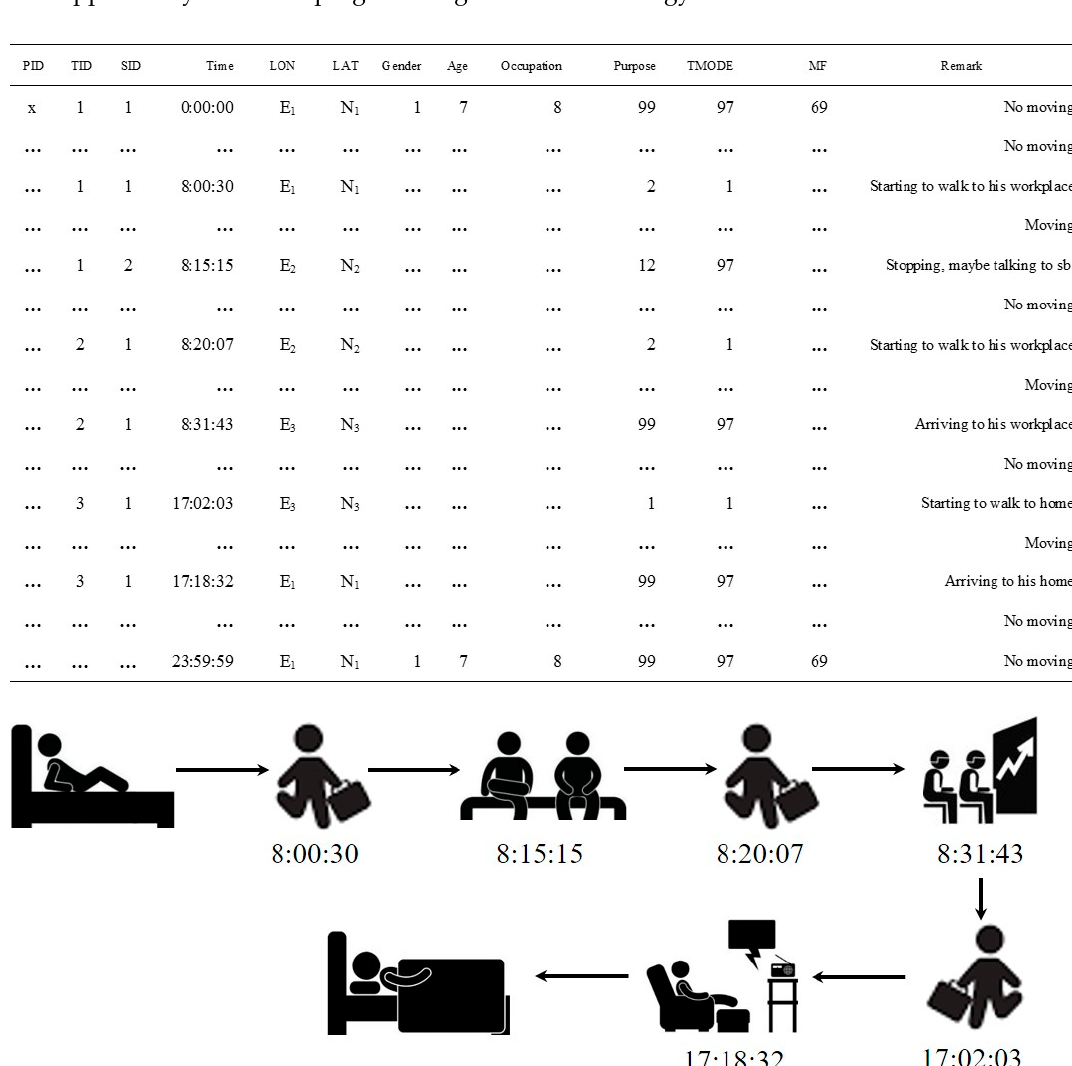
Figure 1. Data structure and explanations of person trip pattern.